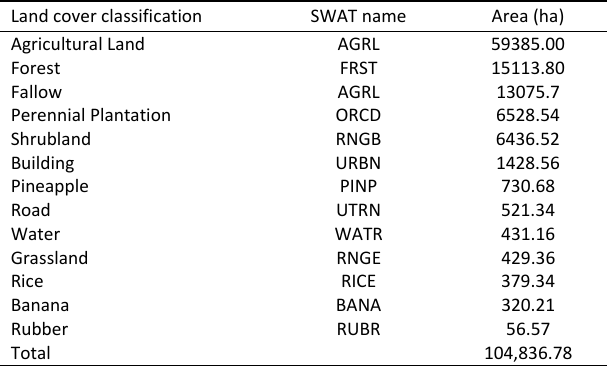
Table 1: Land cover classification of Muleta Watershed